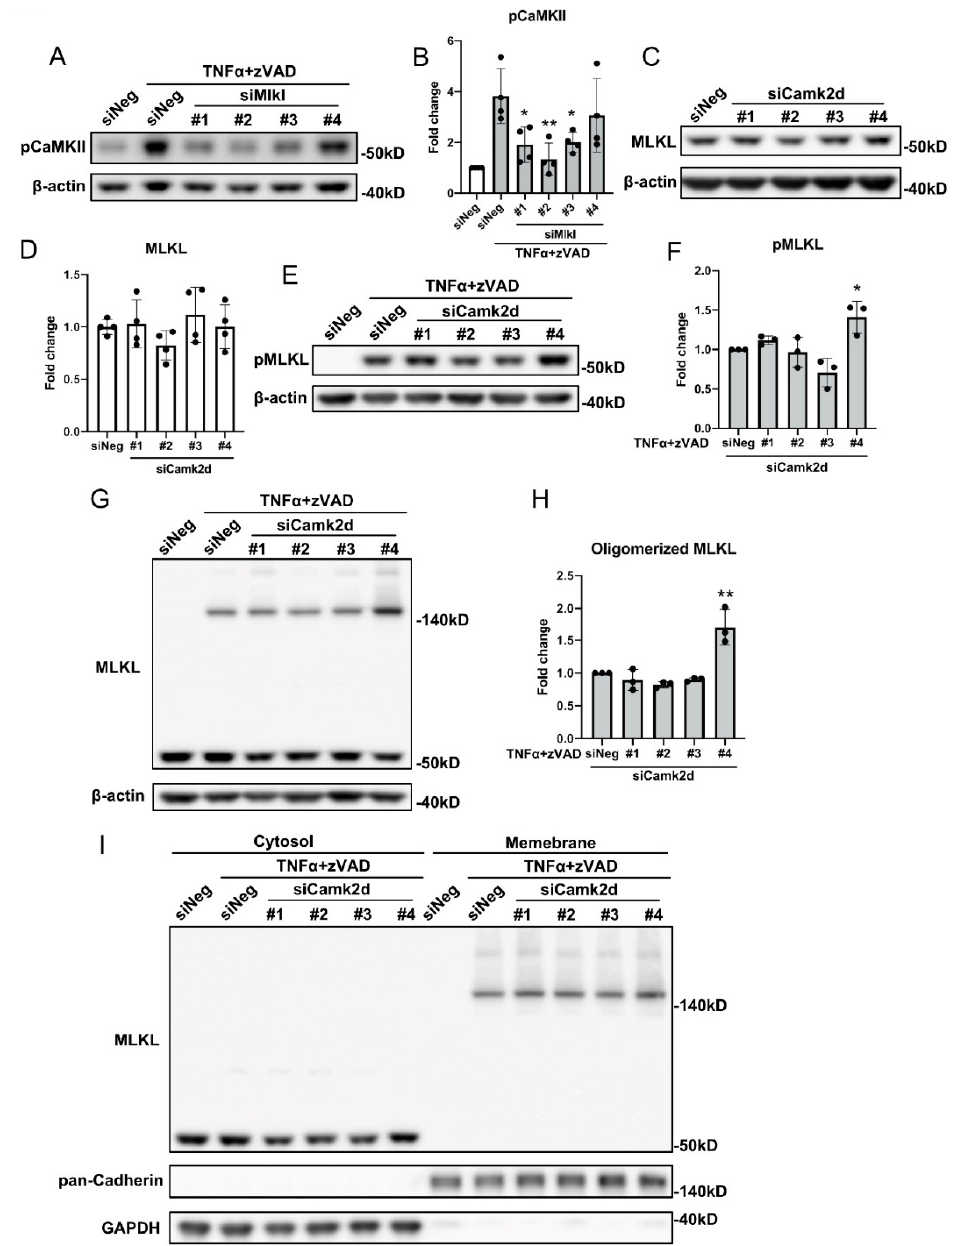
Figure 5. CaMKII activation requires MLKL. ( A ) MOVAS cells were transfected with different siRNAs against Mlkl for 48 h, then treated with 30 ng/mL TNF α plus 60 μ M zVAD for 6 h. Cells were lysed in RIPA buffer and subjected to Western blotting analysis with the indicated antibodies. ( B ) Quantification of ( A ). ( C ) MOVAS cells were transfected with siRNAs against Camk2d for 48 h, cells were lysed in RIPA buffer and subjected to Western blotting analysis with the indicated antibodies. ( D ) Quantification of ( C ). ( E – I ) MOVAS cells were transfected with siRNAs against Camk2d for 48 h, then treated with 30 ng/mL TNF α plus 60 μ M zVAD for 6 h. ( E , G ) Cells were lysed in RIPA buffer ( E ) or 1% digitonin ( G ) and were subjected to Western blotting analysis with the indicated antibodies. ( I ) Cytosol and membrane fractions were sub- jected to Western blotting analysis with the indicated antibodies. ( F ) Quantification of ( E ). ( H ) Quantification of ( G ). Data were presented as mean ± SD of at least three independent experiments. One-way ANOVA was performed in ( B ), ( D ), ( F ), and ( H ). * p < 0.05, ** p < 0.01 compared with TNF α plus zVAD-treated group ( B , F , H ). 4. Discussion